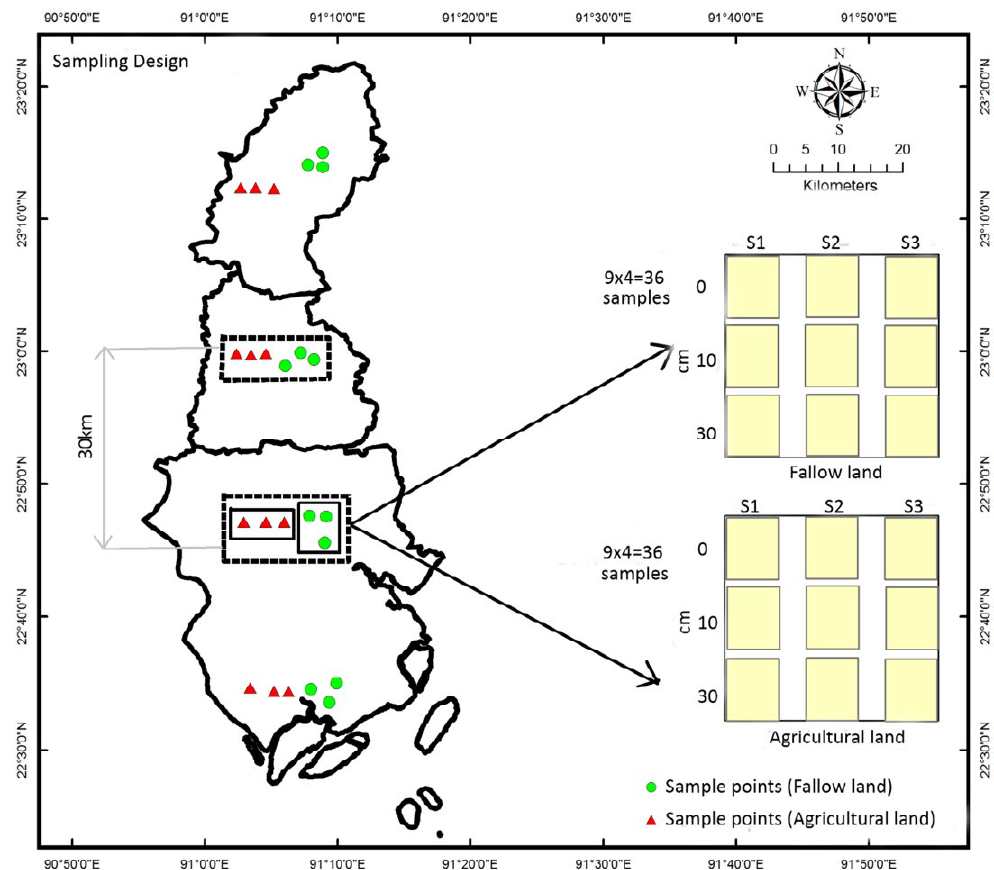
Fig. 2: Map depicting sampling protocol applied for soil sampling in the present study